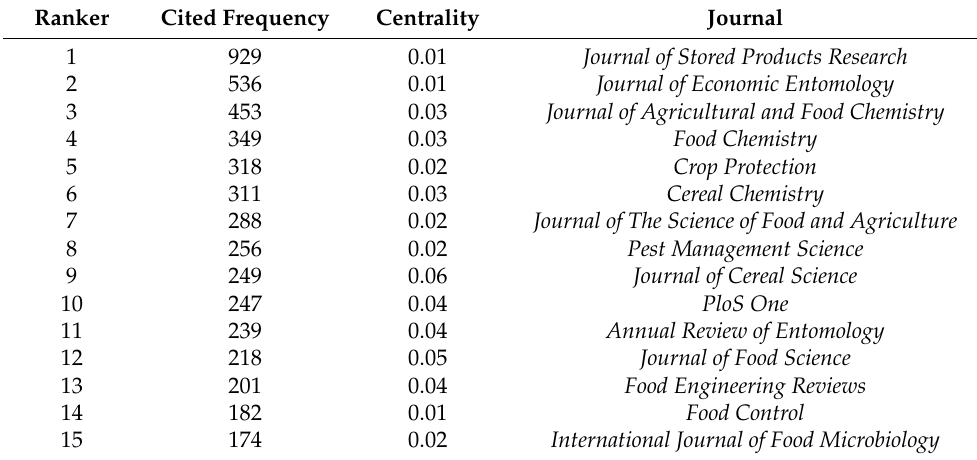
Figure 2. Journal co-citation network. Table 1. Journals information table of the top 15 cited frequency.